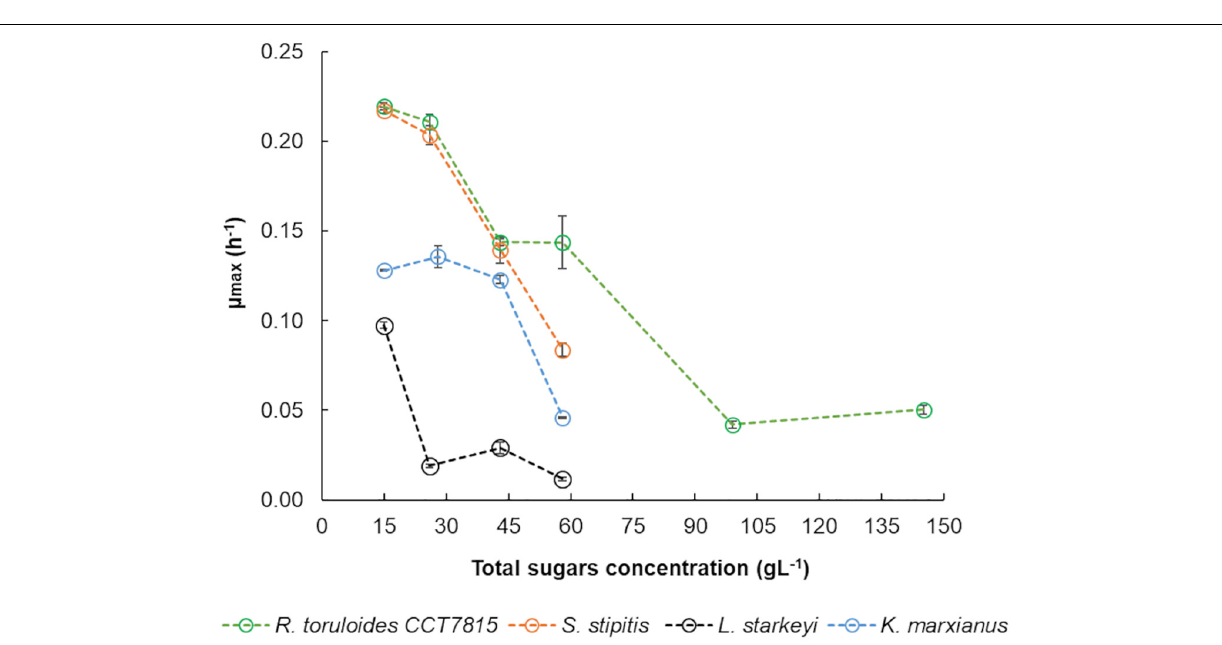
FIGURE 2 | Specific growth rates calculated for R. toruloides CCT 7815, K. marxianus CBS 6556, S. stipitis CBS 5773, and L. starkeyi DSM 70295 in different dilutions of hydrolysate C5-Birch in shake flasks. Errors are expressed in standard